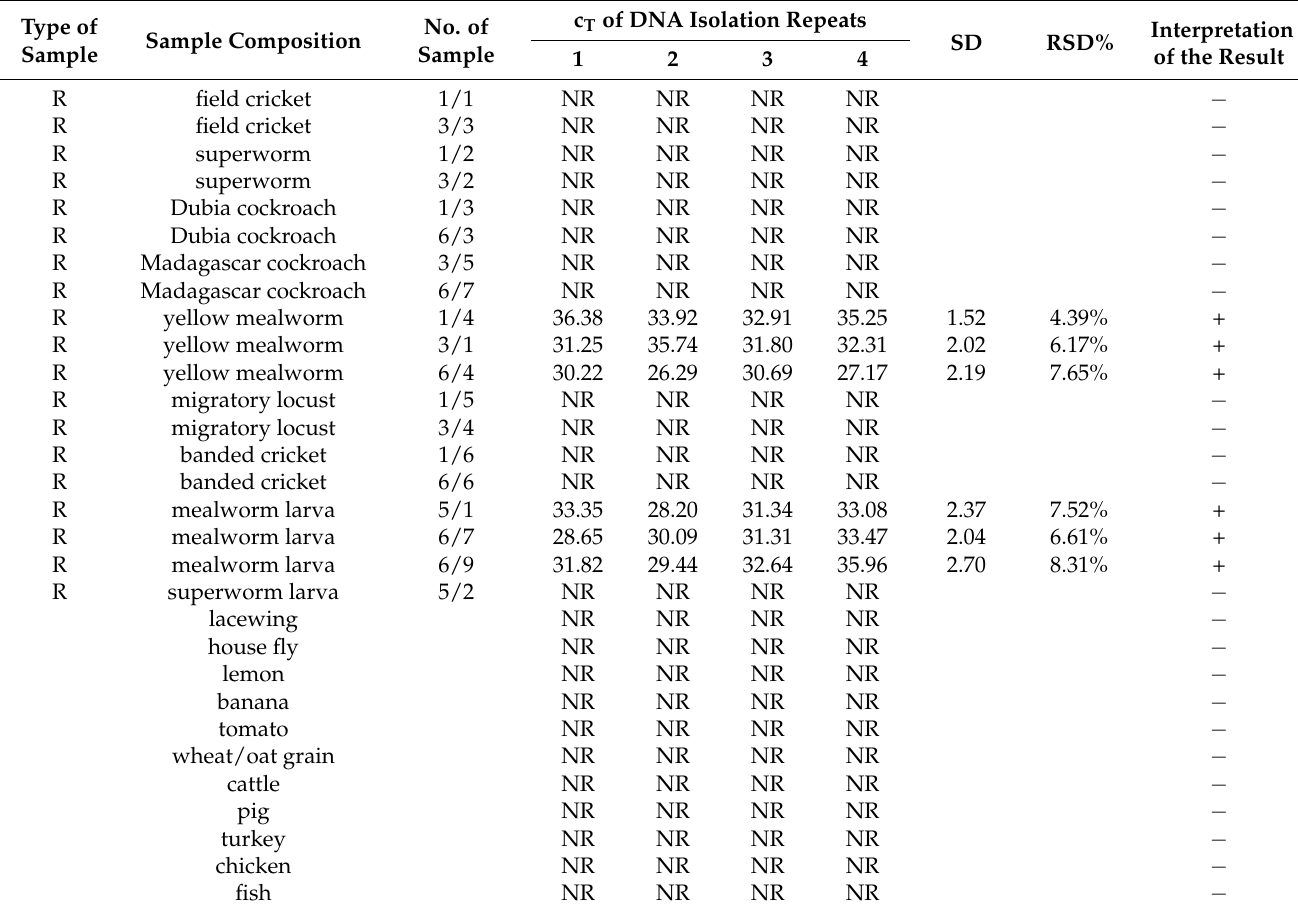
Table 4. The reaction results of yellow mealworm determination from four independent DNA isolations and interpretation of the